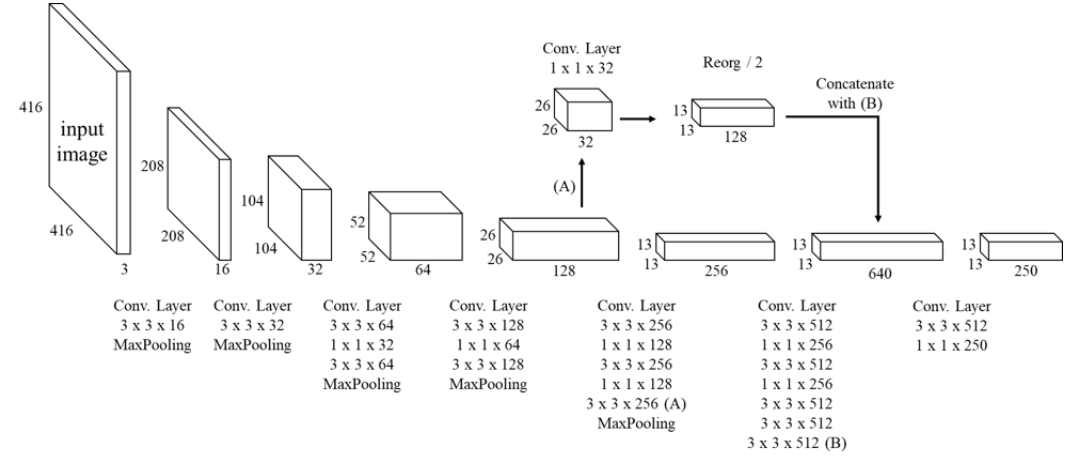
Figure 6. Structure of the proposed YOLOv2